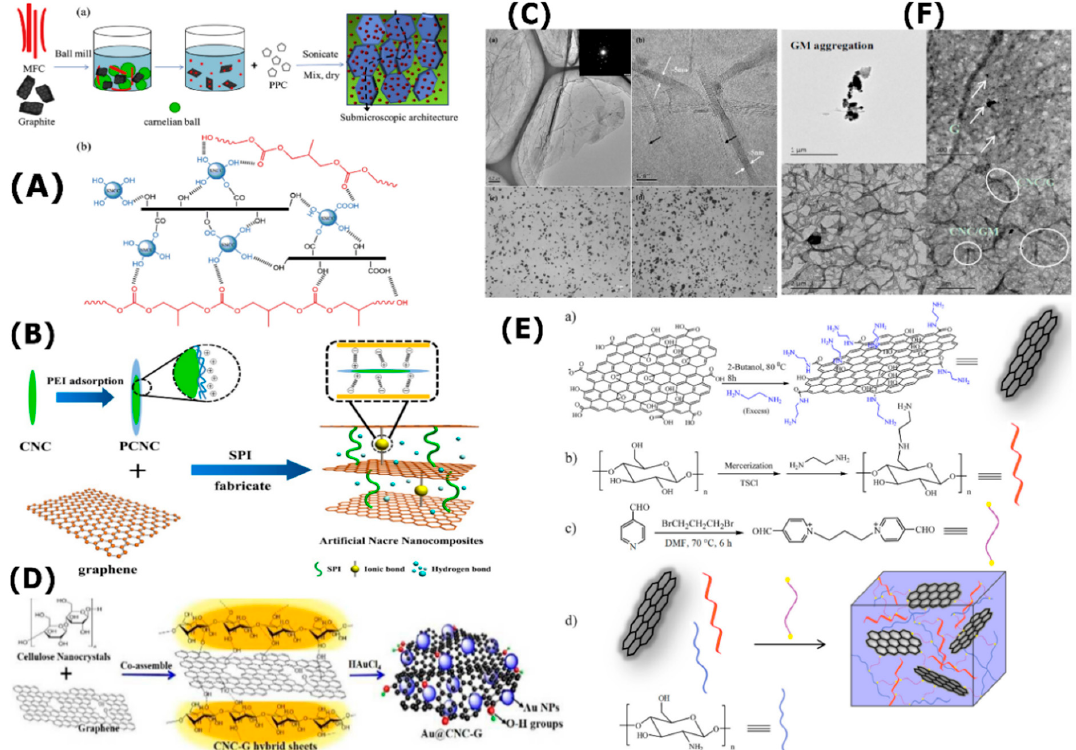
Figure 5. ( A ) Schematic illustration of the production of poly(propylene carbonate) (PPC)/cellulose